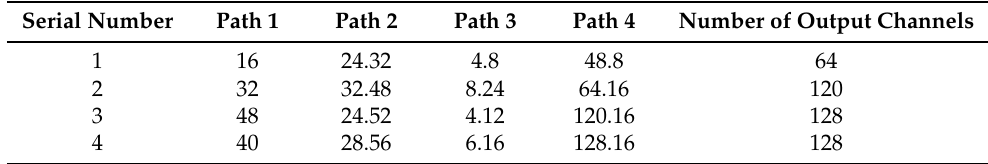
Table 2. Channel parameters for each inception